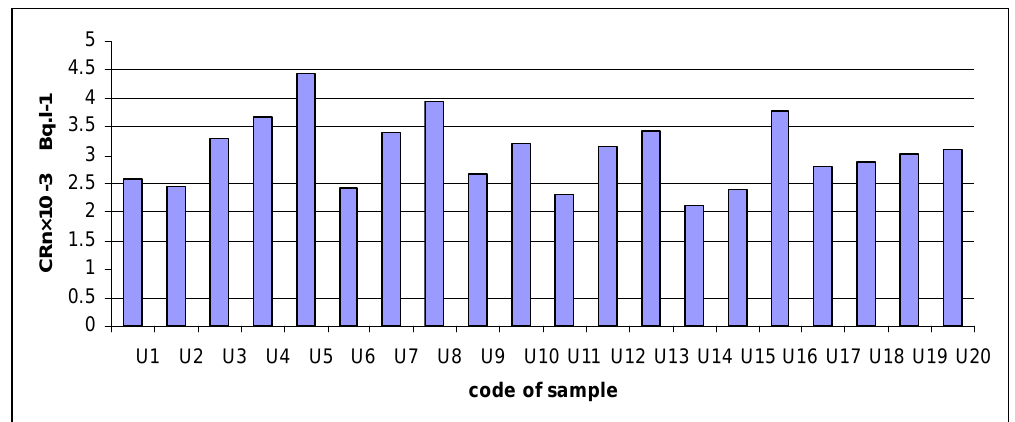
Fig.3: Radon concentration in all urine human samples.